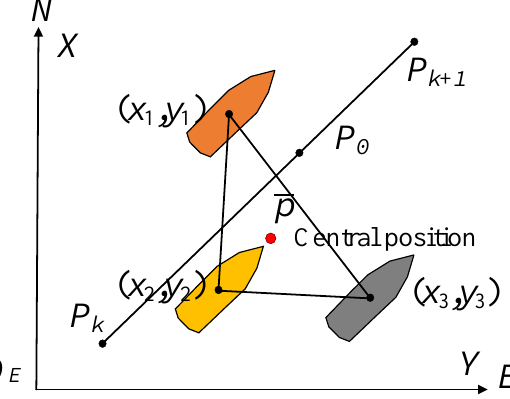
Figure 3. Swarm of MASSs path tracking.